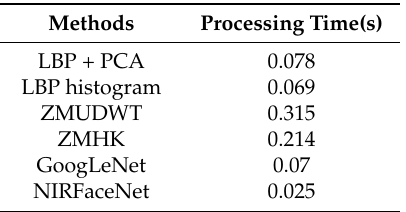
Table 7. Processing times of all the